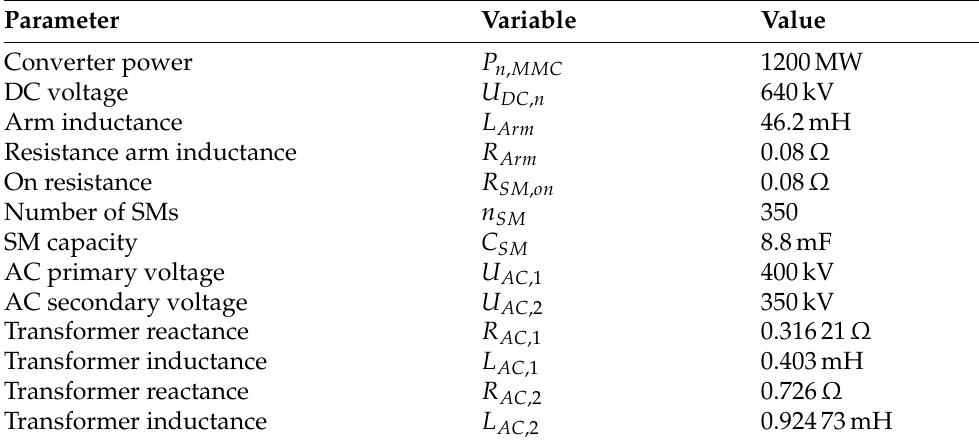
Table 1. Simulated MMC model parameters.